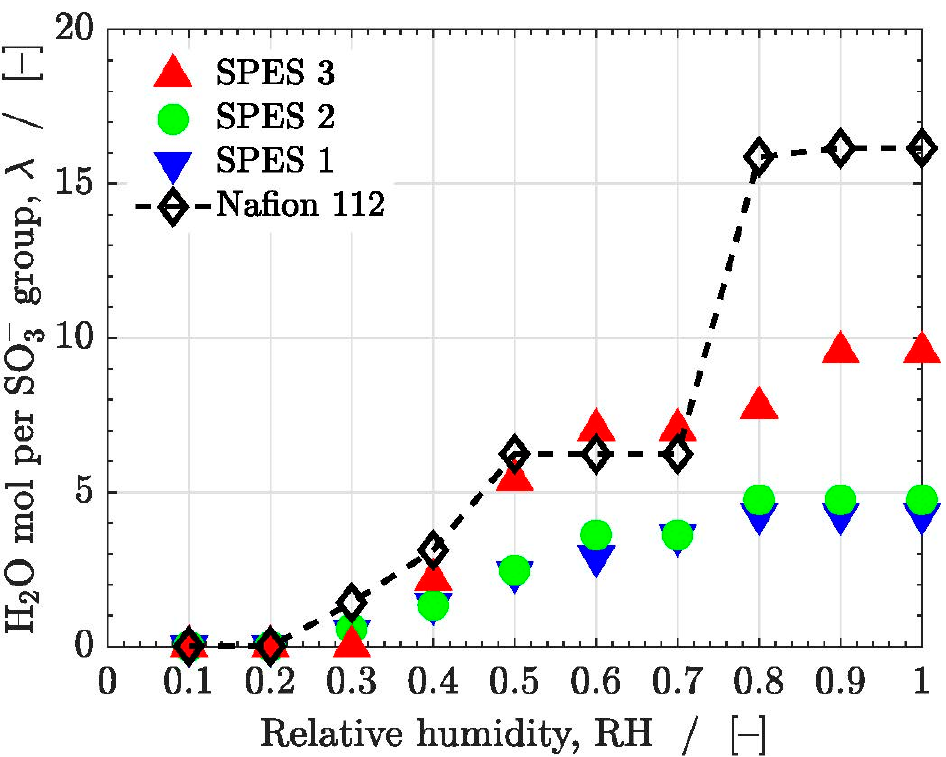
Figure A2. Measured water content (water molecules per sulfonic acid group (molecule)), λ , as a function of relative humidity RH of the SPES membranes. The results for Nafion 112 are also included ( IEC = 0.98 meq g − 1 [49] ).